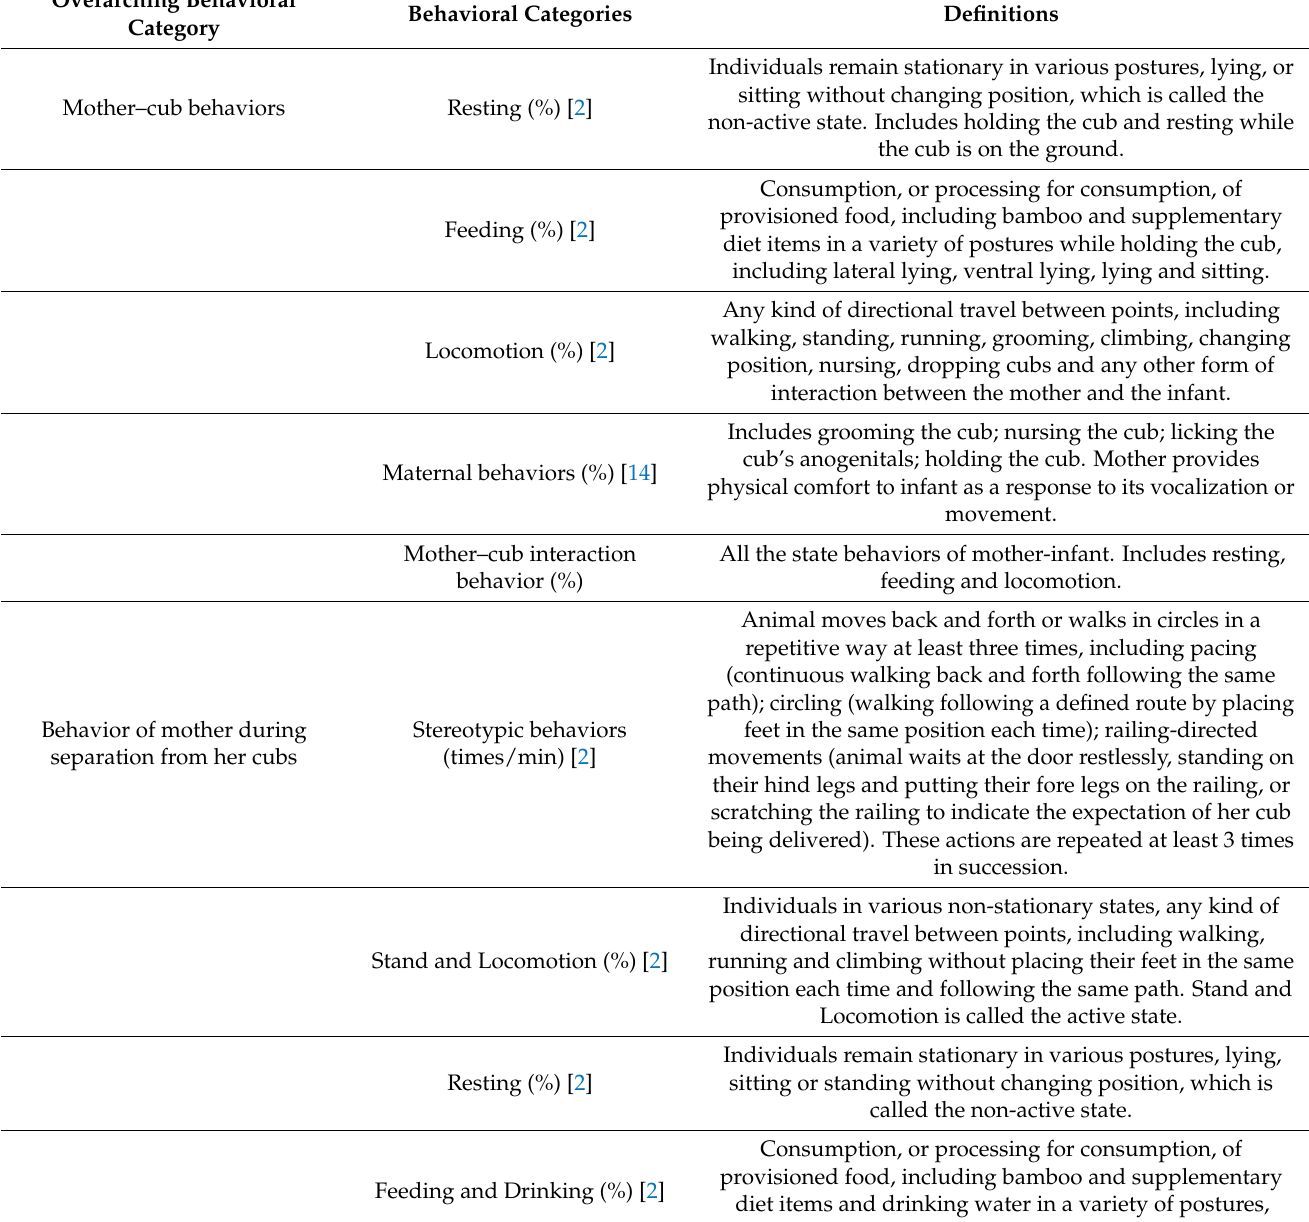
Table 2. Behavioral categories and their